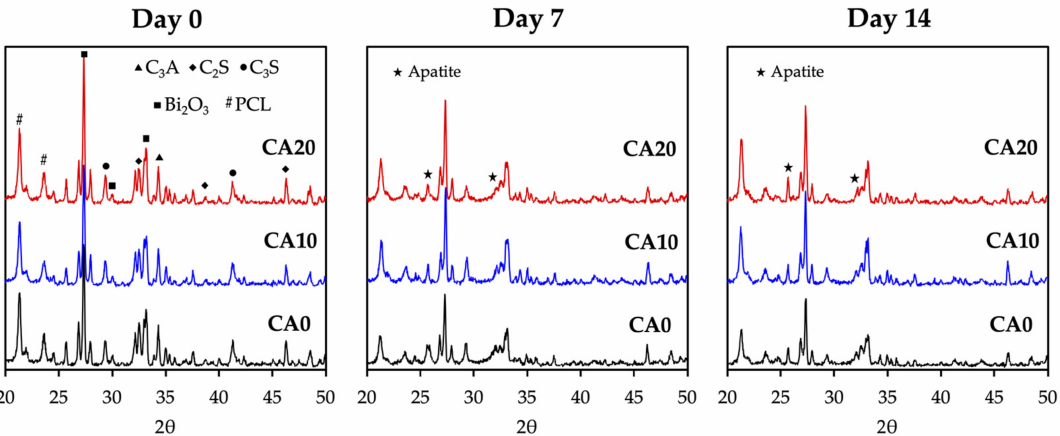
Figure 3. X-ray diffraction (XRD) analysis of CA0, CA10, and CA20 scaffolds before and after the immersion process for 7 and 14